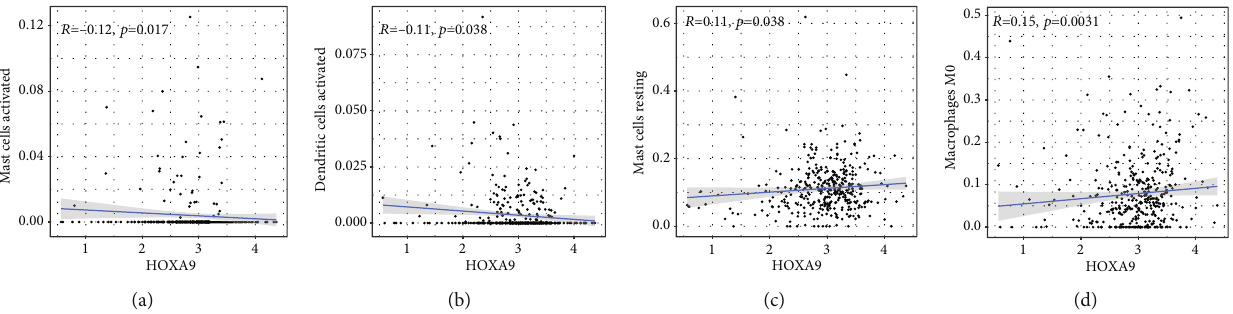
R = – 0.12, p =0.017 R = – 0.11, p =0.038 R =0.15, p =0.0031